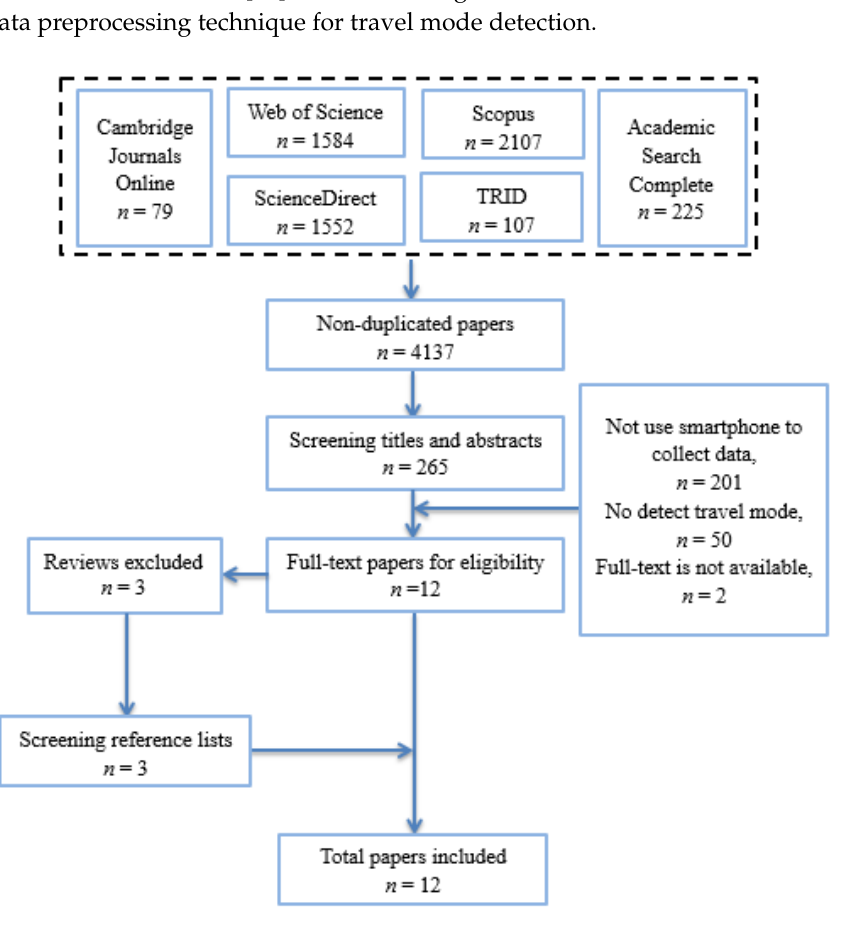
Figure 1. The flowchart of systematic review process.